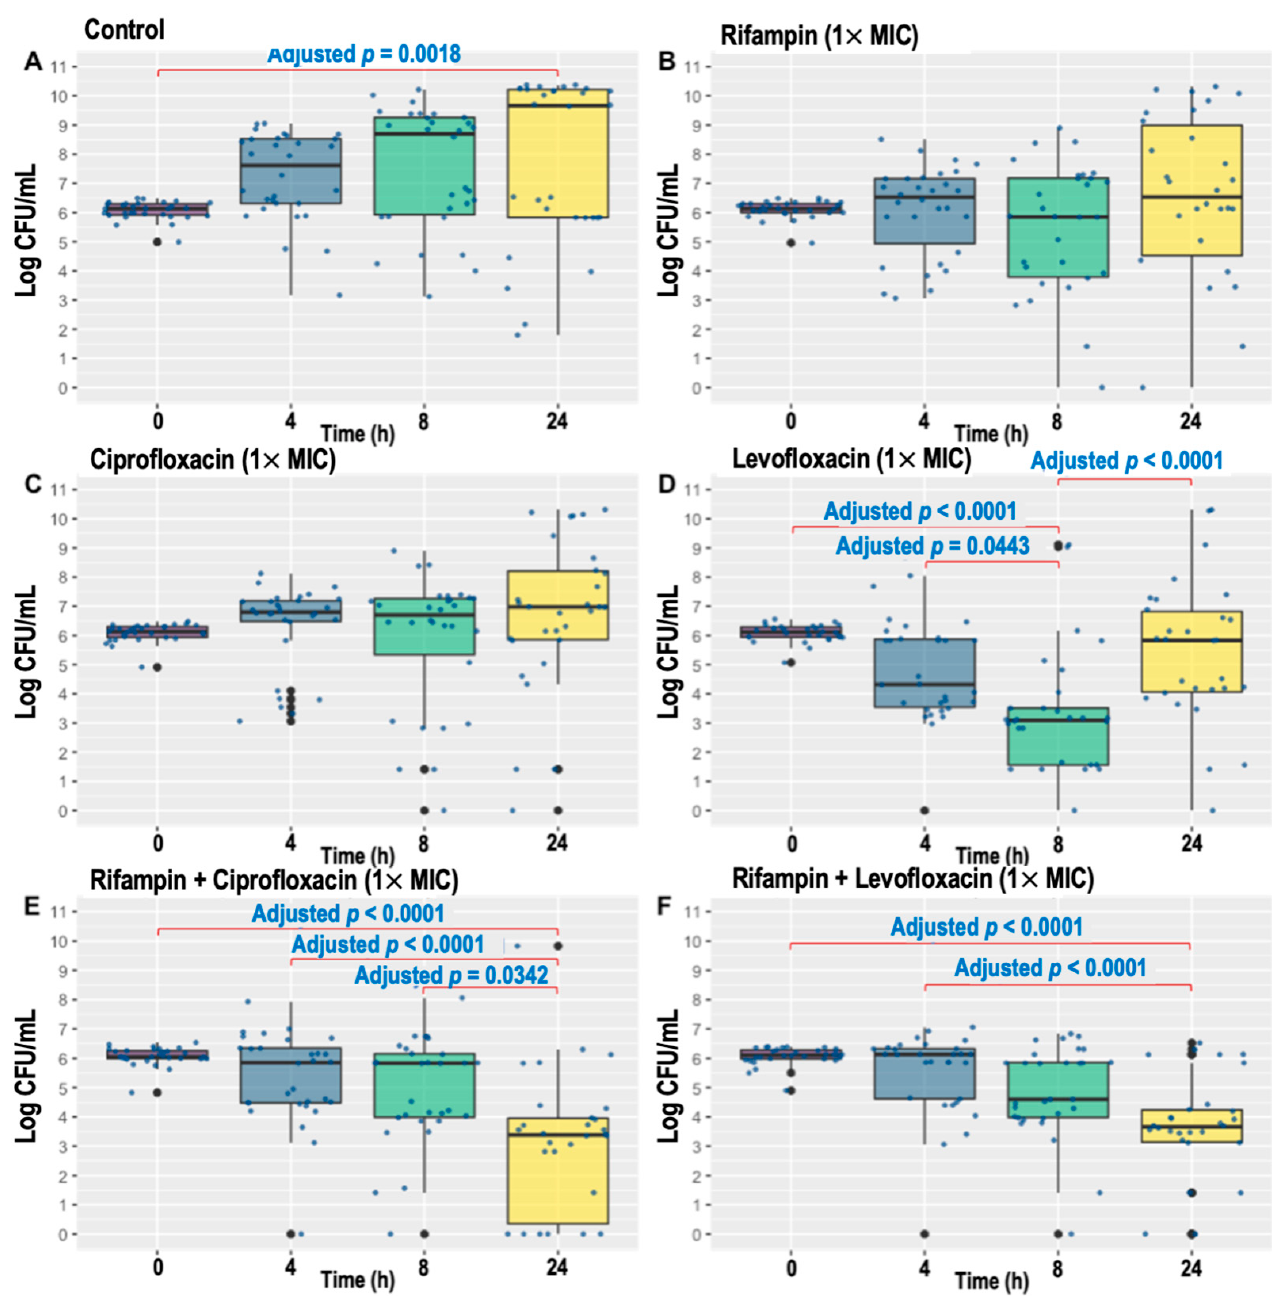
Figure 1. Changes in viable bacterial counts over 24 h after exposure to antibacterial agents at a concentration of 1 × MIC (minimum inhibitory concentration). ( A ) Changes in viable bacterial counts after exposure to control. ( B ) Changes in viable bacterial counts after exposure to rifampin. ( C ) Changes in viable bacterial counts after exposure to ciprofloxacin. ( D ) Changes in viable bacterial counts after exposure to levofloxacin. ( E ) Changes in viable bacterial counts after exposure to rifampin and ciprofloxacin. ( F ) Changes in viable bacterial counts after exposure to rifampin and levo fl ox- acin.